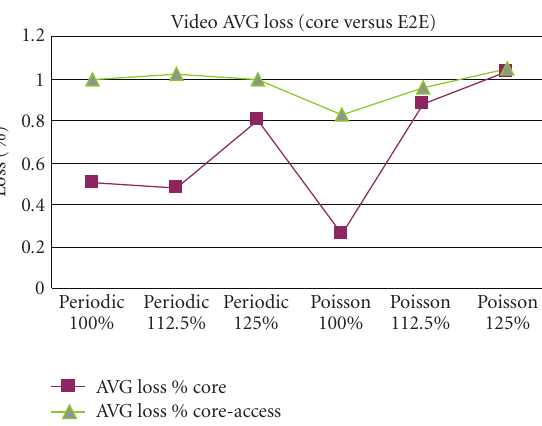
Figure 21: VoIP delay (ms) AS addition .